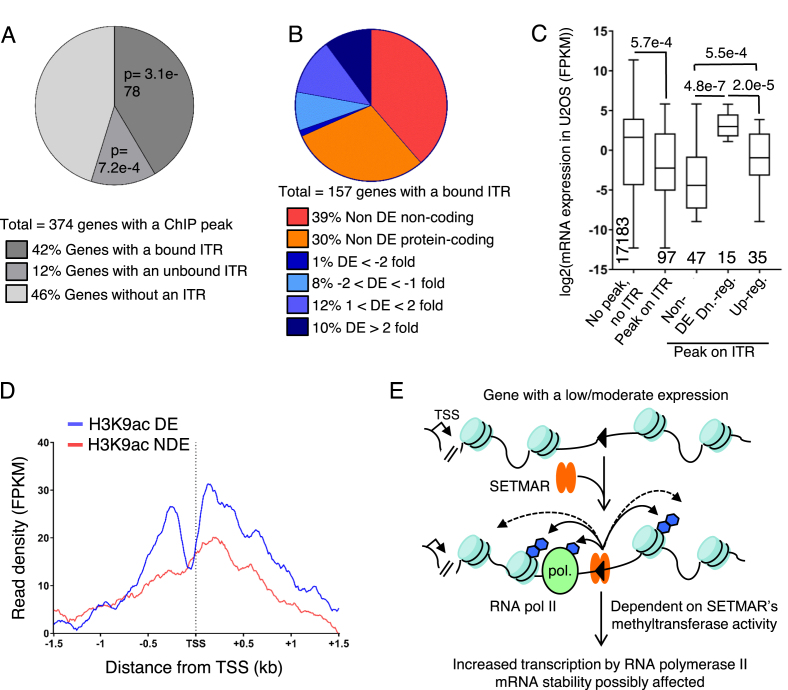
Distribution of SETMAR ChiP peaks and mode of action. (A) The distribution of intragenic ChIP-exo peaks with respect to the presence of intronic ITRs. 42% of genes have a ChIP-exo peak within 500 bp of an ITR. 12% of genes have a ChIP-exo peak >500 bp distant. 46% of genes with a ChIP-exo peak have no intronic copies of the ITR. P-values were determined using a hypergeometric distribution. (B) The distribution of intronic SETMAR-bound copies of the ITR with respect to non-coding and coding genes and the degree of differential expression in the SMF and SMFN cell lines. A third of the genes have their ITR bound in the ChIP-exo experiments are significantly differentially expressed in the SMF cell line. A third of the non-differentially expressed genes are non-coding and therefore have not been detected by the RNA-seq protocol used. DE, differentially expressed. (C) Boxplot showing the expression level of the 97 protein coding genes with a bound ITR (ChIP-exo peak <500 bp distant) compared to the vast majority of genes that have no ITR and no ChIP-exo peak. The rightmost three plots are subclasses of the 97 genes with a bound ITR. P-values were determined using a Mann-Whitney U test. DE, differentially expressed; Dn., down; reg., regulated. (D) Metaprofiles for the presence of H3K9ac marked-nucleosomes were generated for the 50 differentially expressed (DE) and 47 non-DE genes from part C using the ENCODE data for U2OS cells. TSS, transcriptional start site. (E) We present a model for transcriptional regulation by SETMAR. A gene is undergoing a moderate amount of transcription. An intronic ITR has positioned nucleosomes on either side owing either to SETMAR binding or the intrinsic positioning effect of the ITR sequence itself. SETMAR methylates nearby nucleosomes and/or RNA polymerase II associated factors such as snRNP70. Up-regulation of gene expression by SETMAR is dependent on its methyltransferase activity and is mediated by an increase in RNA polymerase II transcription and by a possible change in mRNA stability. Blue hexagons, methyl groups.